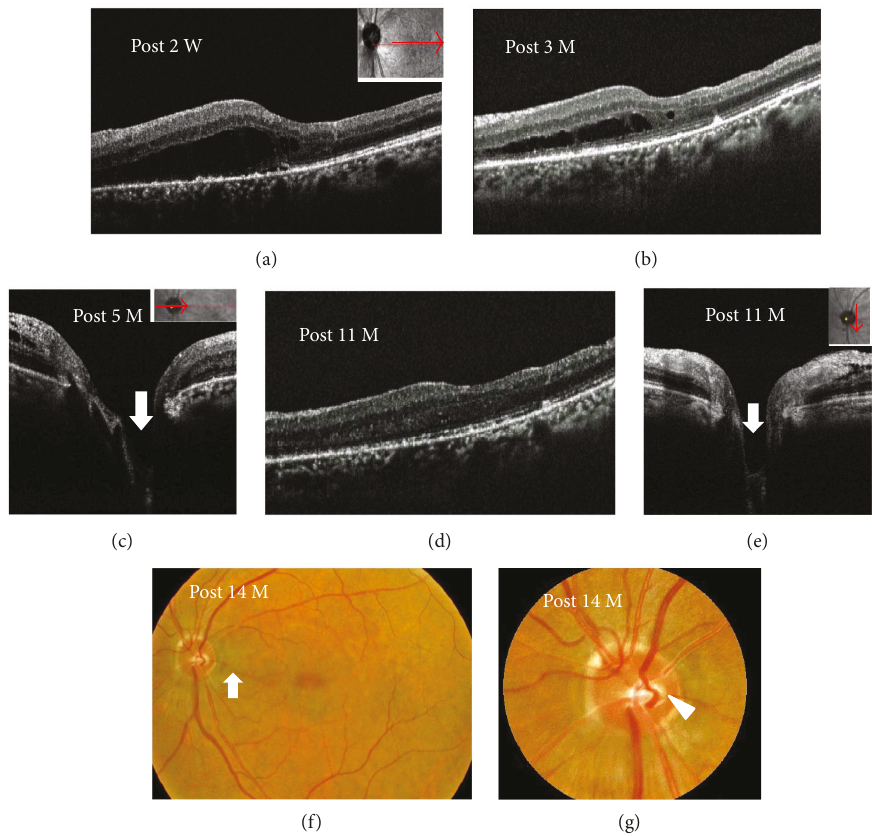
Figure 4: Findings after surgery in case 4. (a – e) Spectral domain optical coherence tomography images revealed that an optic disc coloboma (c, e, arrows) became clear after epipapillary membrane removal. Macular schisis also gradually decreased and was resolved 11 months after surgery (a, b, and d). (f, g) A retinal nerve fi ber layer defect (f, arrow) corresponding to the coloboma (g, arrowhead) was evident together with the disappearance of the retinal schisis 14 months after